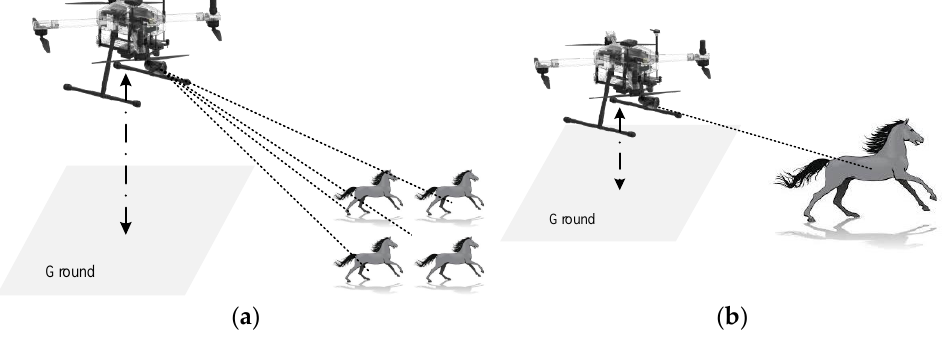
Figure 1. ( a ) The targets are small in the image; ( b ) The targets are large in the